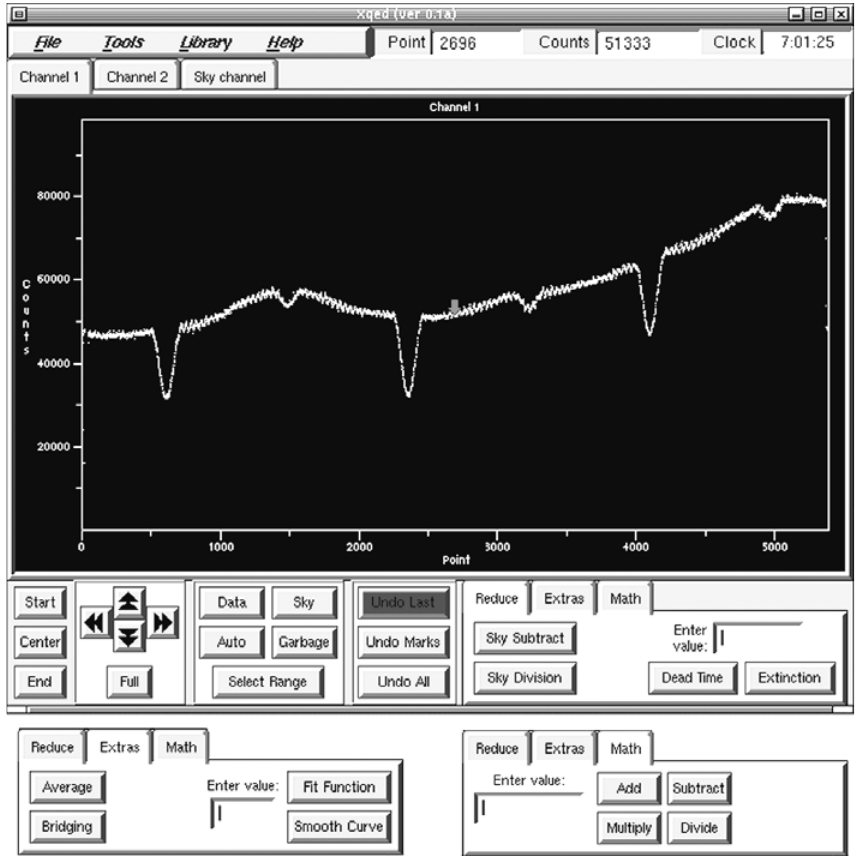
Fig. 1. The main reduction window of the XQED package. The two tab windows at the bottom are the other functions included in the lower right